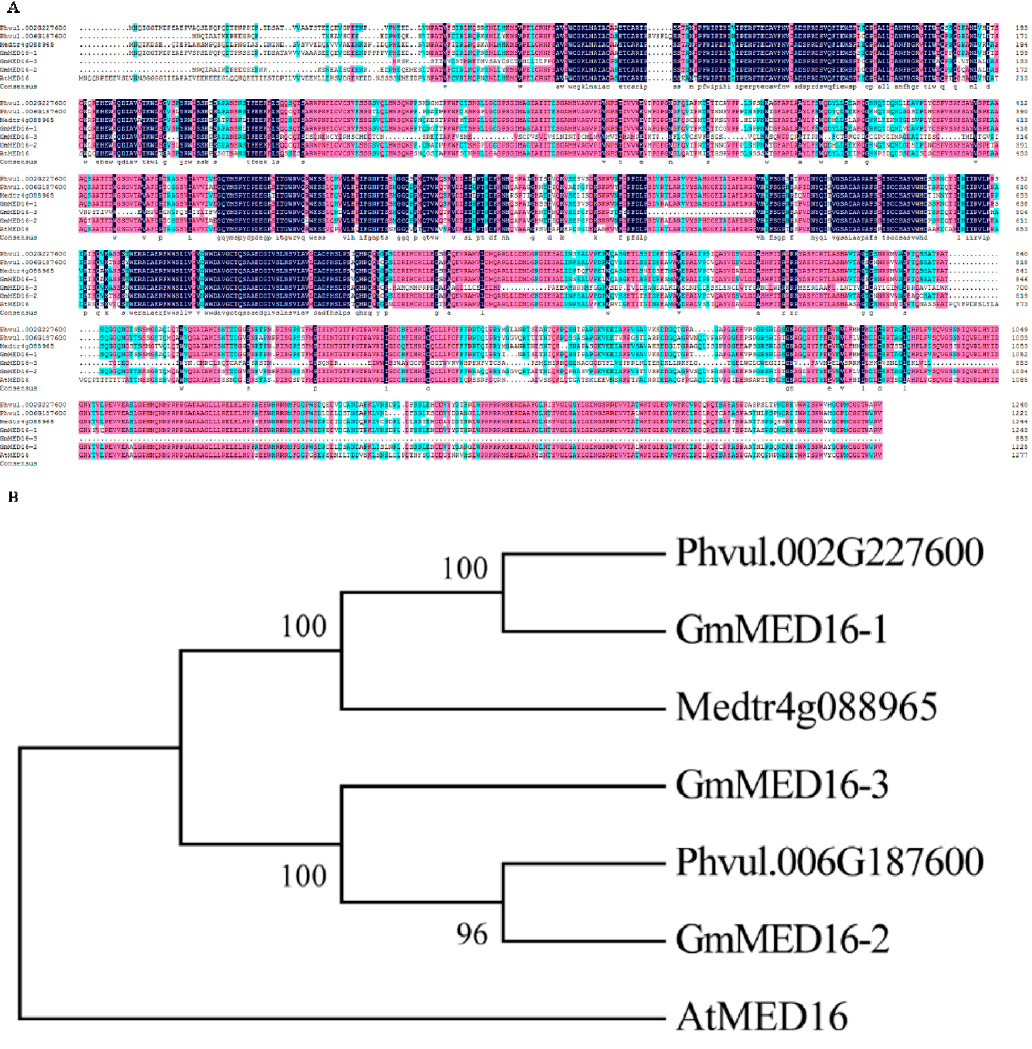
Figure 4. Sequence alignment and phylogenetic analysis of MED16 proteins from soybean, Arabidopsis , Phaseolus vulgaris , and Medicago truncatula . ( A ) Sequence aligment was performed using MED16 proteins from Arabidopsis , Phaseolus vulgaris , Medicago truncatula and Glycine max . Amino acid marked with boxes of di ff erent colors represents the similarity di ff erence among these sequences. Dark blue represents 100%, pink represents > 80%, cyan represents > 60%. ( B ) Sequences used for phylogenetics analysis were same as these in alignment. The phylogenetic tree was constructed by MEGA 6.0 using the Neighbor-Joining method. The evolutionary distances were computed using the p-distance method. Bootstrap values in percentage (1000 replicates) are indicated on the nodes. To investigate the physiological role of soybean MED16 genes, the expression pattern of GmMED16 - 1 gene in the root s , stems, leaves, and flowers of soybean were analyzed by quantitative